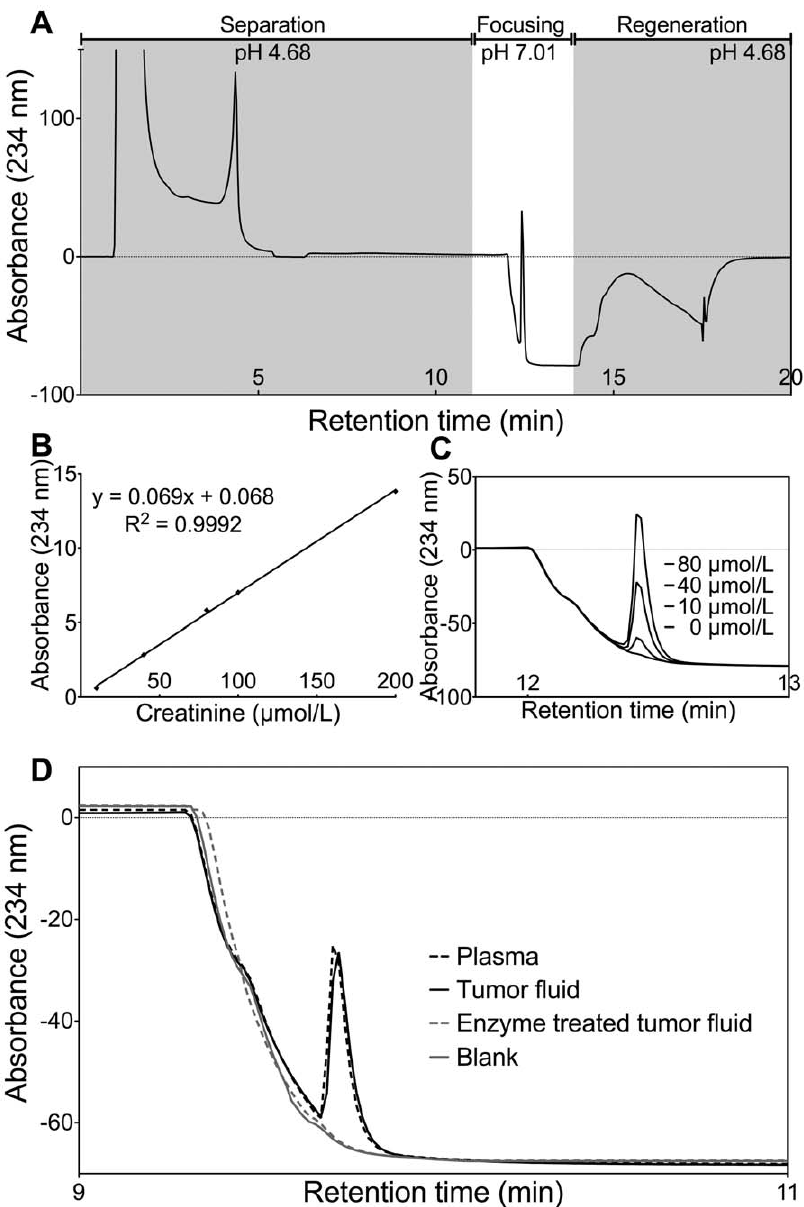
Figure 2. Measurement of creatinine by HPLC. A: The complete chromatogram from HPLC creatinine analysis. Deproteinized samples were injected on two strong cation exchange columns in series at pH 4.68, where creatinine will be positively charged and retained. TCA and other contaminants are not retained at this pH and were washed out in the first five minutes, while creatinine was passed into a third column for further separation and fixation. By changing the buffer pH to 7.01 in the third column the creatinine molecule was rendered neutral, reducing retention and thus producing a sharp and well-defined peak with absorbance at UV 234 nm. After a focusing step the buffer pH changes back and the columns were regenerated. B: Calibration curve for creatinine with standard concentrations 0, 10, 40, 80, 100 and 200 mM. C: Chromatograms for creatinine standards 0, 10, 40 and 80 m mol/L used for calibration. D: By analyzing tumor fluid and plasma samples before and after enzyme hydrolysis by creatininase and creatinase the method’s specificity could be assessed. The chromatograms from analysis of plasma, tumor fluid before and after enzyme hydrolysis, and a blank run are shown.